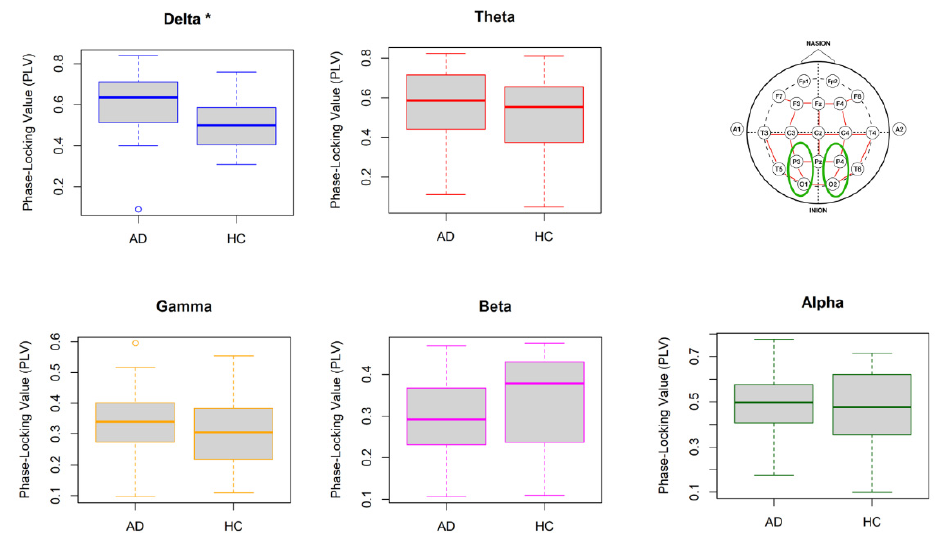
Figure 6. The PLVs obtained from the homotopic pair in the parieto-occipital region (Pair C). Plots marked with * indicate a statistically significant difference ( p < 0.05) between AD patients and HCs.